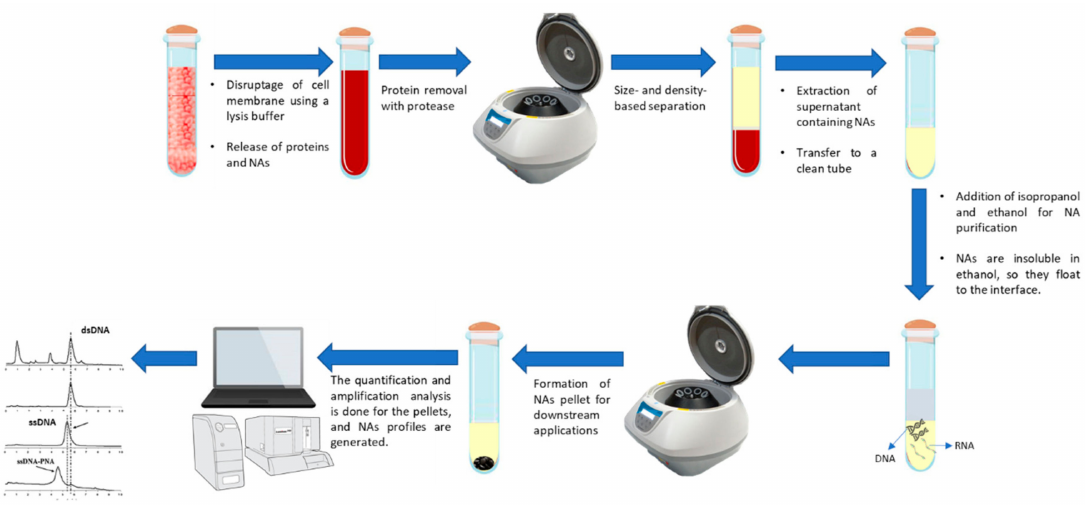
Figure 3. Commonly used extraction procedure for nucleic acids. Prior to circulating tumor nucleic acids (ctNAs) detection, several methods have been utilized in order to properly isolate these biomarkers.